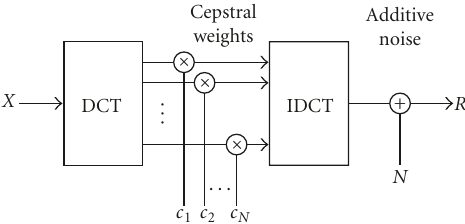
Figure 2: Block diagram of model A. The processing is applied to each time frame in the